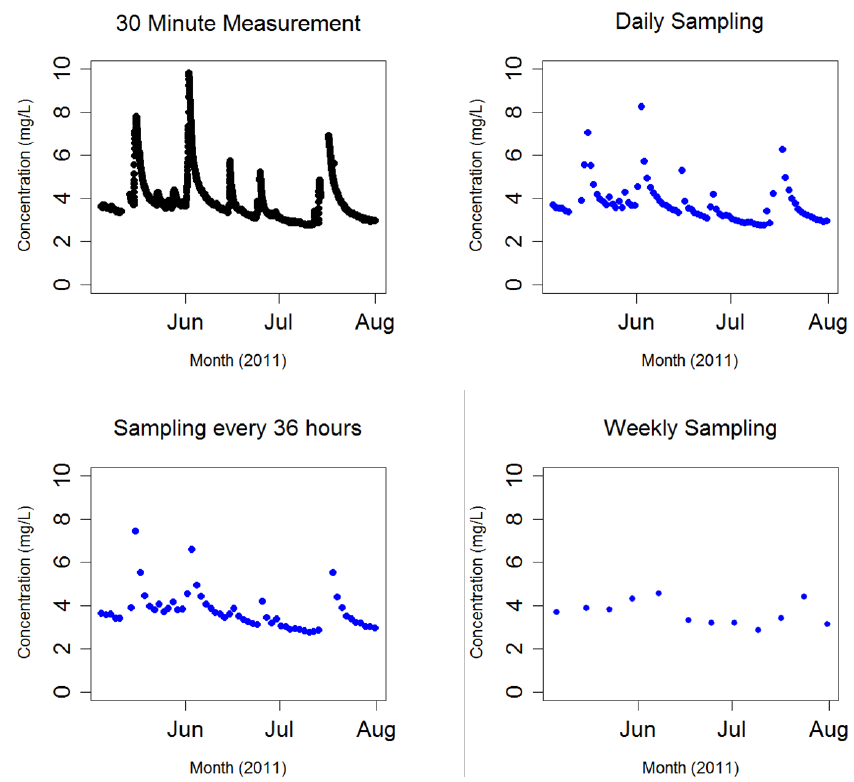
Figure 3. The effect of sampling frequency on DOC concentration; the frequency of DOC concentration measurements greatly affects the DOC concentration time-series, predominantly by narrowing the range of DOC concentrations measured as well as reducing the observable dynamic detail present in the DOC concentration